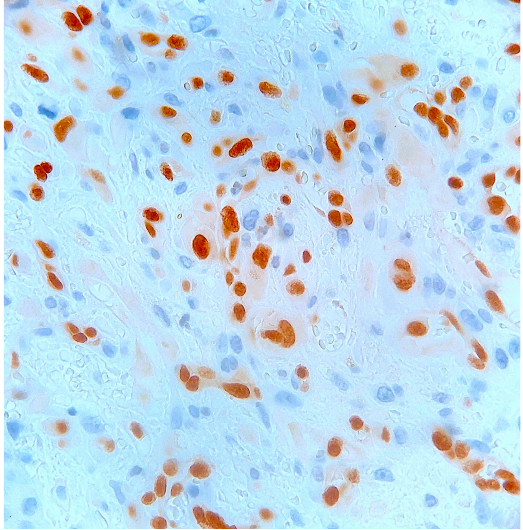
Figure 8. The tumour cells express nuclear reactivity for ERG (immunoperoxidase revealed with diaminobenzidine).